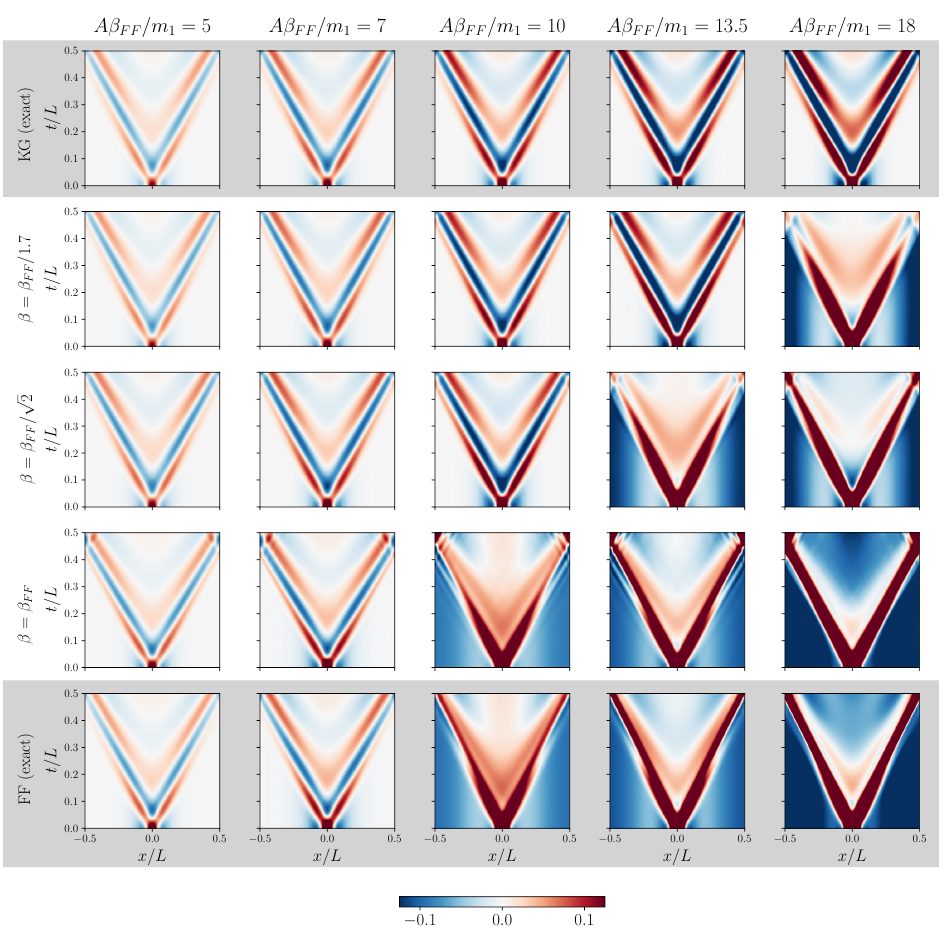
〈 ˆ ρ ( x , t ) 〉 Figure A.2: The time evolved QFT expectation value of m − 1 for five differ- j 1 σ = 2 / 3. The ent amplitudes of the external field with bump width bump-width m (cid:112) 1 / 1.7, β = β / interaction parameters are β = 0 (Klein–Gordon limit) β = β 2 and FF FF β = β . For the computation of the free fermion dynamics, both TCSA and the nu- FF 〈 ˆ ρ ( x , t ) 〉 merically exact method was used. From the Klein–Gordon dynamics, m − 1 (cid:112) j 1 〈 ∂ π ) which corresponds to ˆ ϕ ( x , t ) 〉 with 1 / = 1.7 was obtained by rescaling m − 1 x j 1 / 1.7 point. For the TCSA quantities, extrapolation was used based on the β = β FF = 24,26,28 and data with cut-offs e c